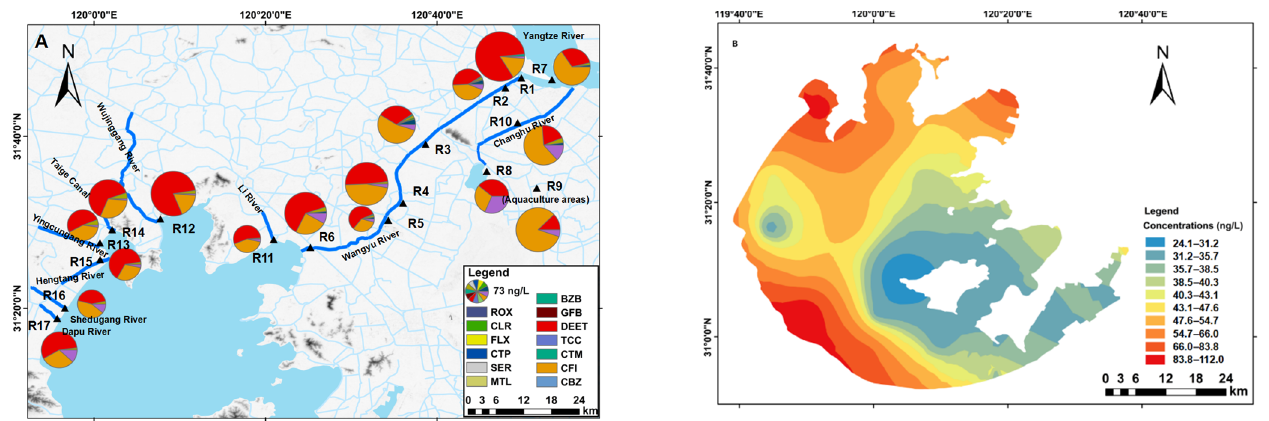
Figure 3. Spatial distributions in the concentrations of PPCPs in the ( A ) river networks and ( B ) Taihu Lake.